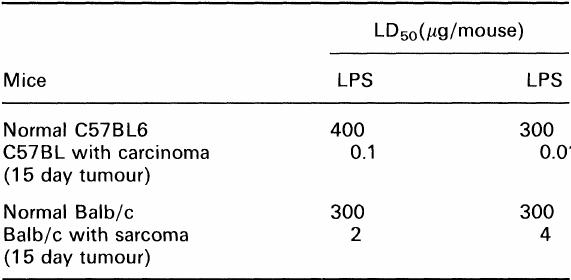
Table 3. Hypersensitivity of LLC and EMT6 tumour bearing mice to LPS or recombinant